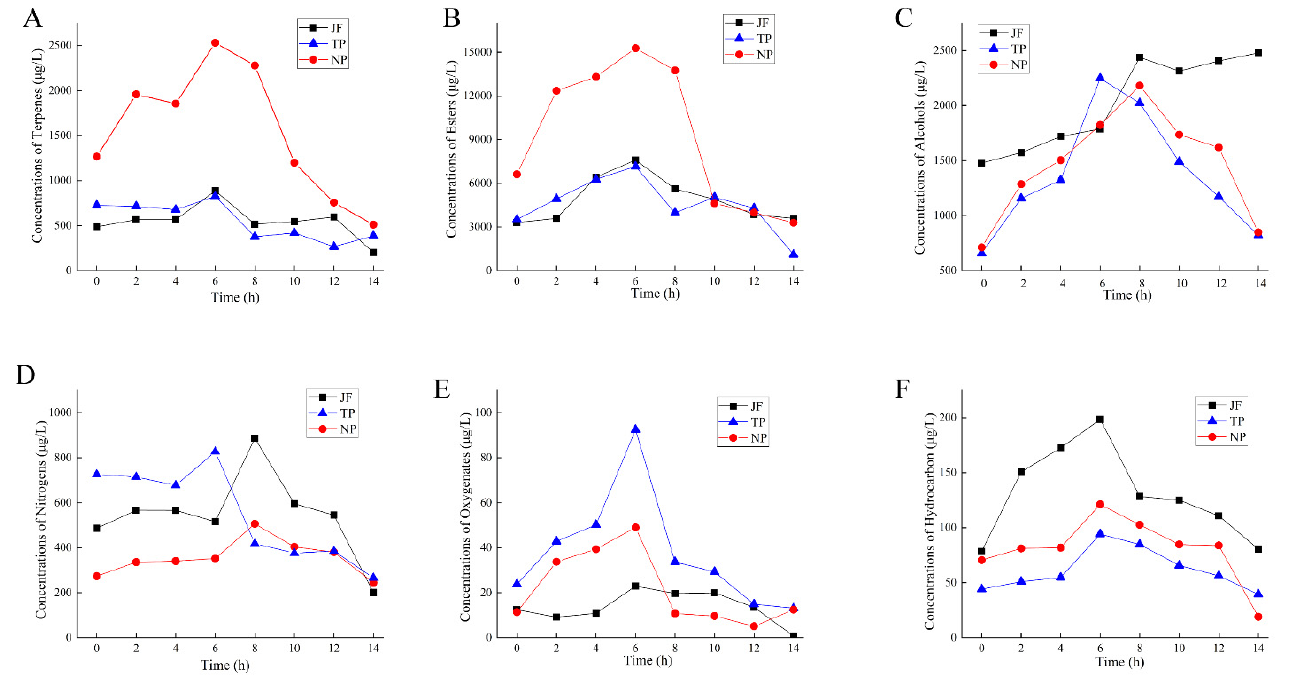
Figure 8. Changes in main aromatic substances of jasmine during the scenting process. ( A ) terpenes. ( B ) esters. ( C ) alcohols. ( D ) nitrogens. ( E ) oxygenates. ( F ) ( B ) esters. ( C ) alcohols. ( D ) nitrogens. ( E ) oxygenates. ( F ) hydrocarbons.